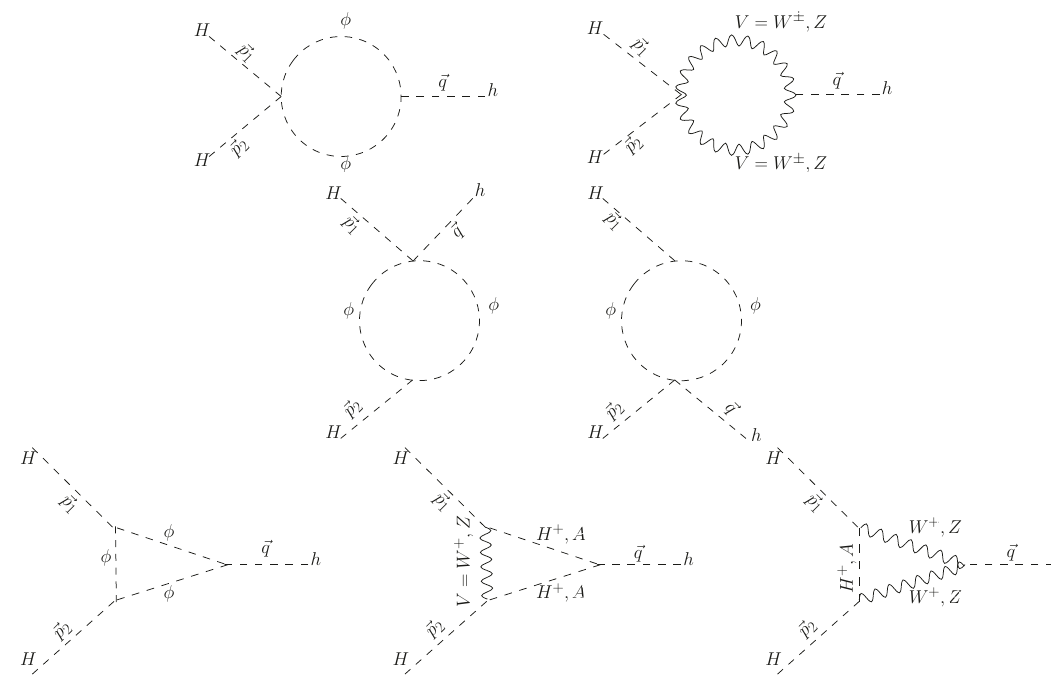
H h (cid:0) (cid:0)